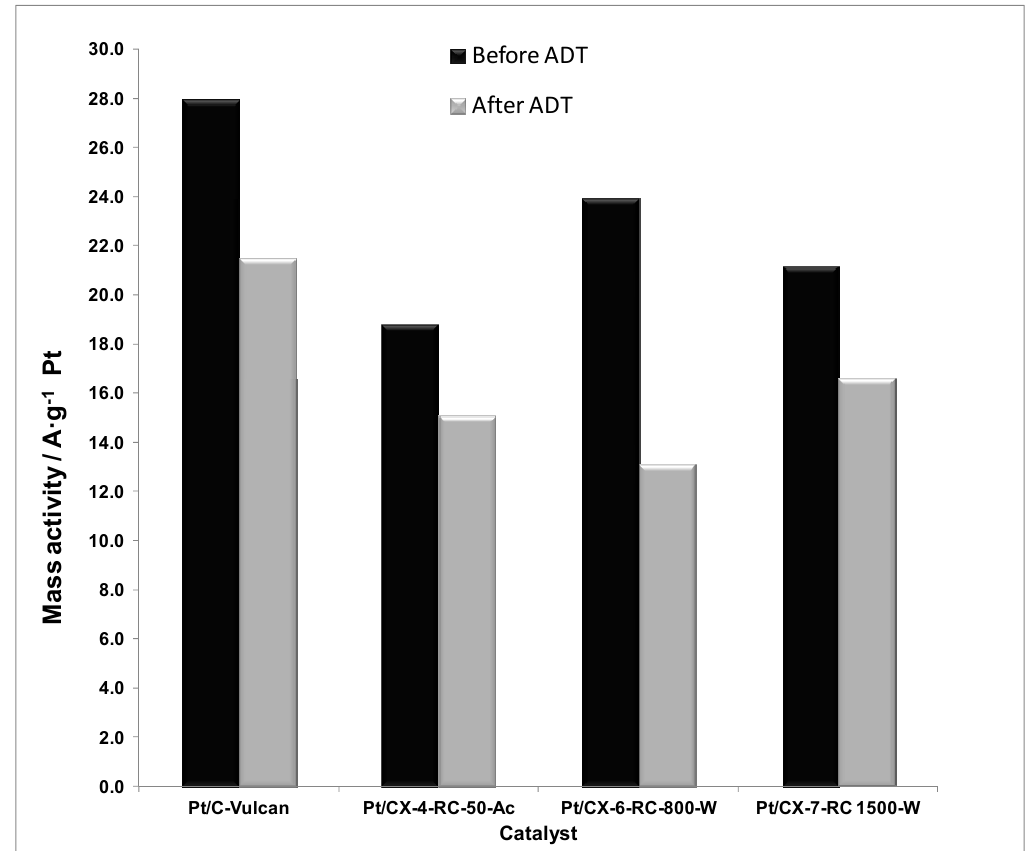
Figure 12. Mass activity at 0.80 V vs . RHE (half-cell, oxygen fed, 0.5 M H before and after accelerated degradation tests